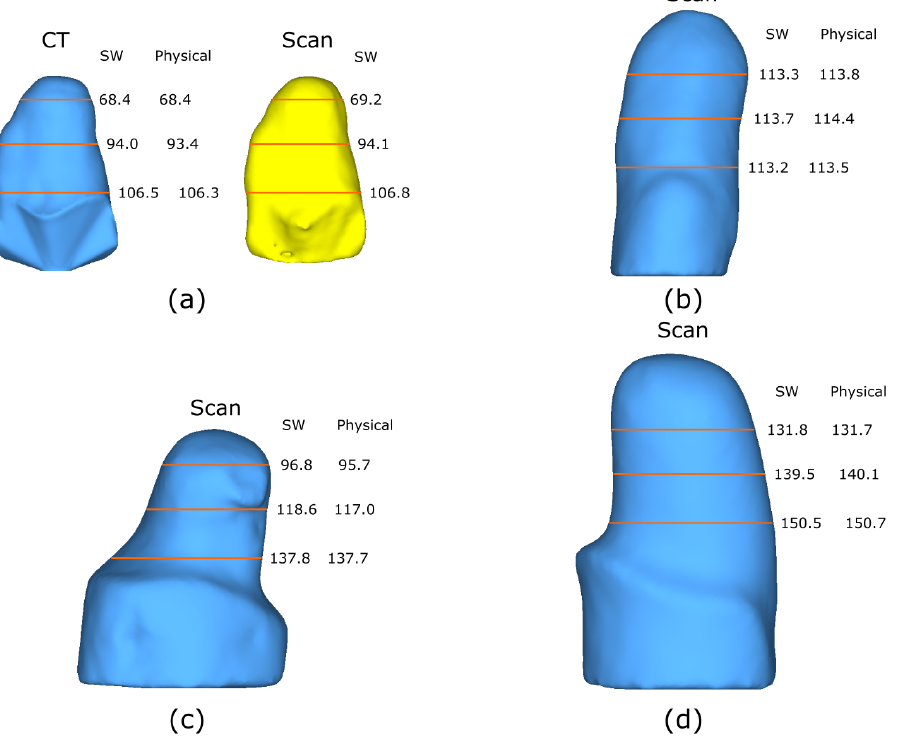
Figure 14. Diameter measurements across all 4 models. Comparison for both SW and physical diameters at 3 different heights (units are in mm). ( a ) M1-transtibial proto model. ( b ) M2-transtibial plaster. ( c ) M3-transfemoral plaster. ( d ) M4-transfemoral